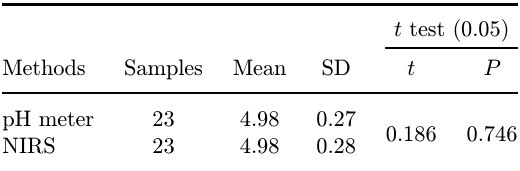
Table 4. The results of paired t test.